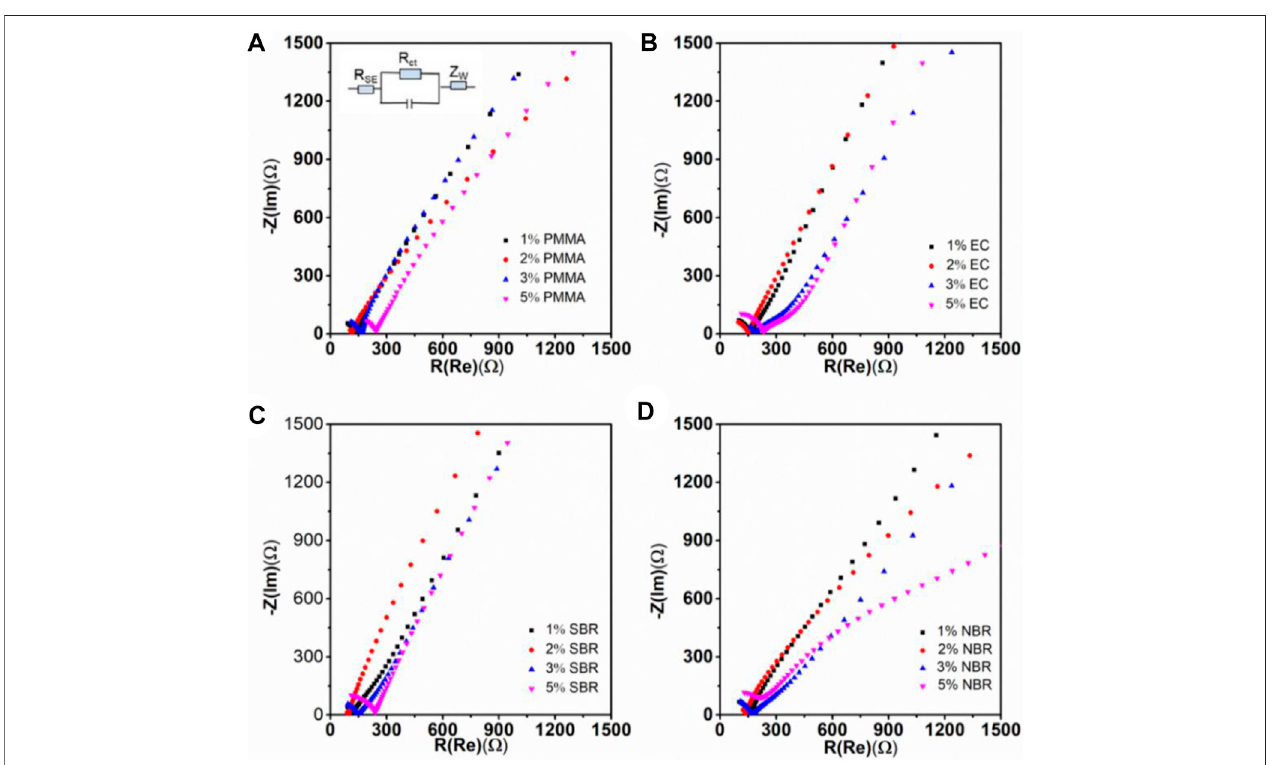
FIGURE 6 | Nyquist plots of cathode composites with various amount of binders: (A) PMMA, (B) EC, (C) SBR, and (D) NBR.